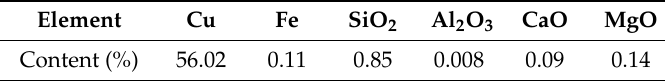
Table 1. Chemical composition of the